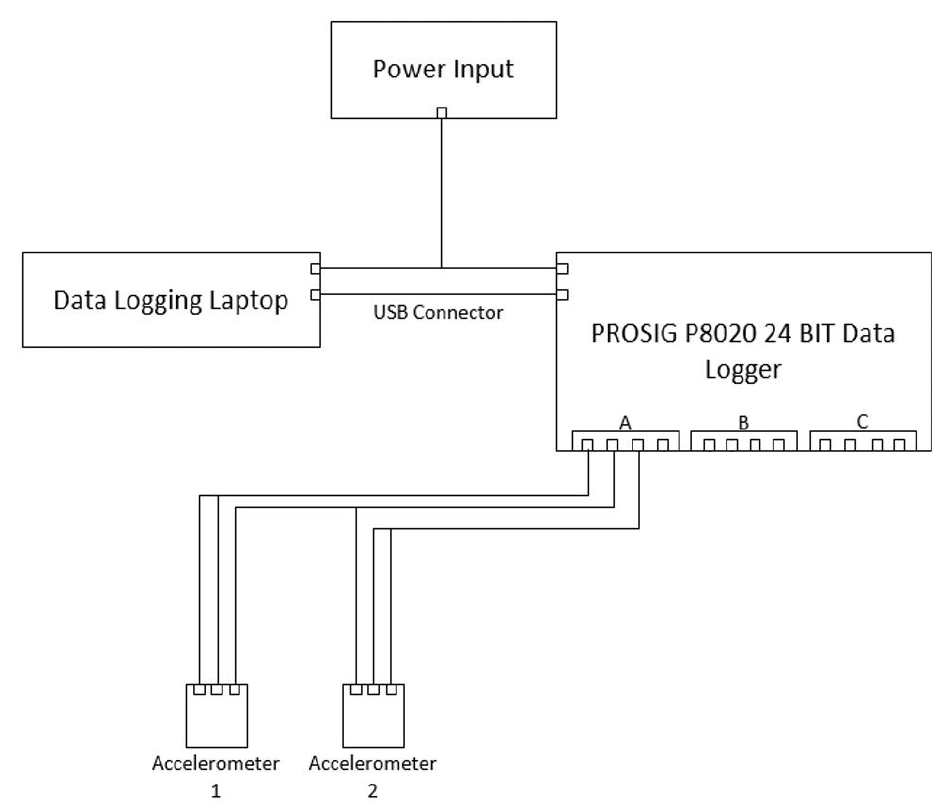
Figure 2. Testing wiring